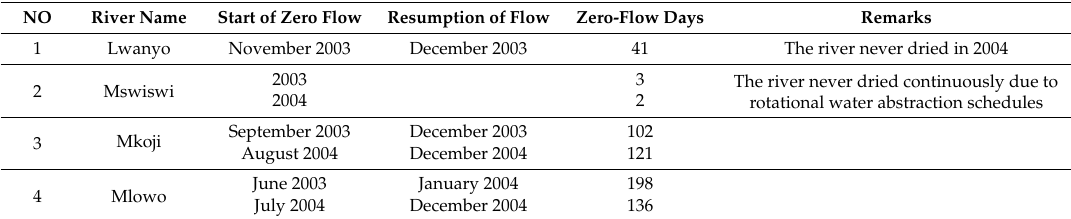
Table 1. Flow resumption in the Mkoji